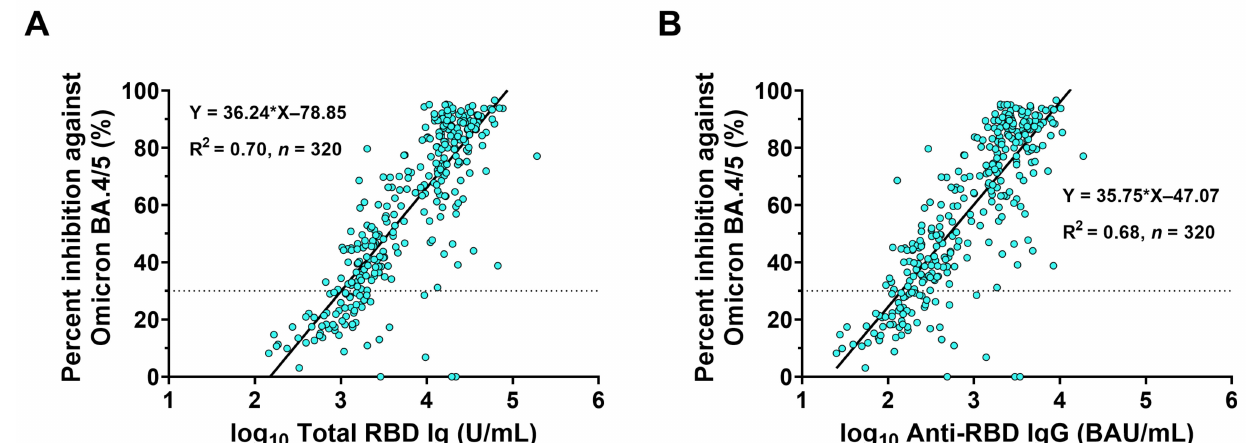
Figure 5. Predicted linear correlation between the binding antibody and neutralizing activity against Omicron BA.4/5 using the sVNT 50 . A total of 320 sera (at day 0 ( n = 160) and day 28 ( n = 160)) from individuals who received a fourth dose of BNT162b2 and mRNA-1273 were tested for total RBD Ig and anti-RBD IgG levels and neutralizing activity against Omicron BA.4/5 using sVNT 50 . Linear regressions (solid line) showing the relationship between percent inhibition against Omicron BA.4/5 and ( A ) logarithm (log 10 ) (total RBD Ig) (U/mL) or ( B ) log 10 (Anti-RBD IgG) (BAU/mL). The linear equation and the r-square (R 2 ) were calculated according to a simple linear regression model between the transformed log 10 of the binding antibody and the percentage of inhibition. The dotted line indicates the seronegativity of the neutralizing activity of SARS-CoV-2 Omicron BA.4/5